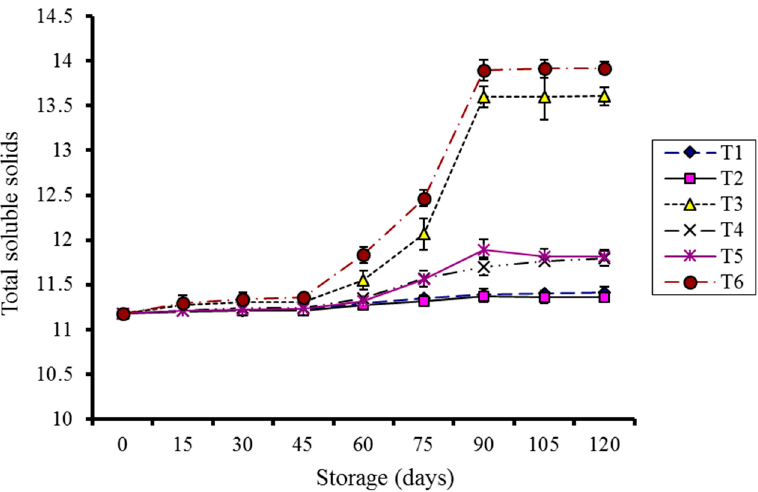
Figure 3. Effect of CMC and guargum-based silver nanoparticle coatings on the total soluble solids of kinnow fruit stored at 4 and 10 °C during storage. The vertical bars represent standard error of the means. Values represented as mean ± SE of three replicates.